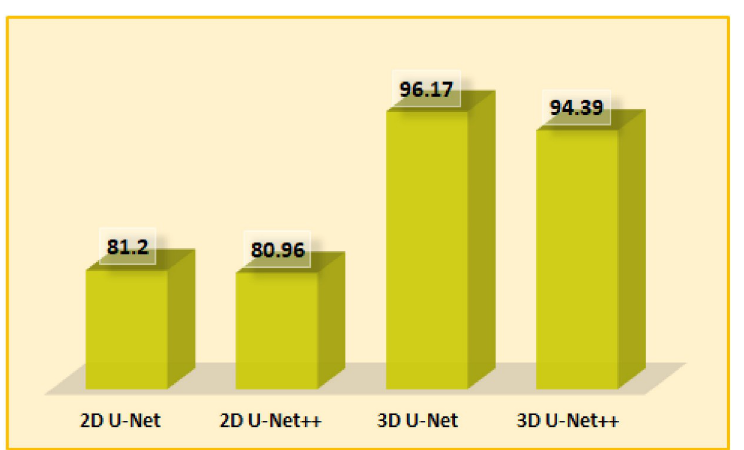
Fig 25. Performance comparison for 2D and 3D tumor segmentation (average prediction Dice scores).